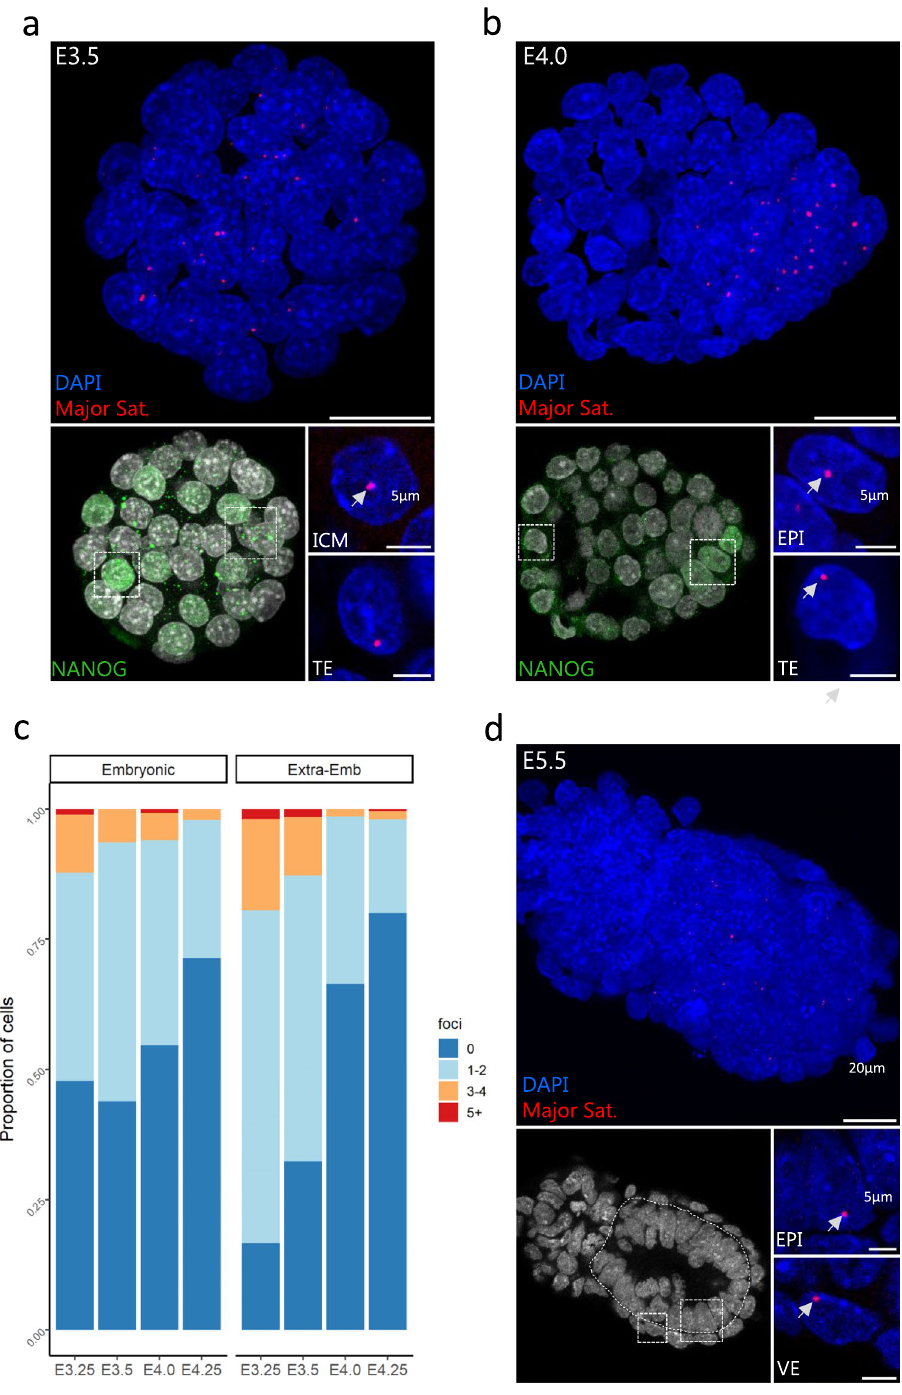
Figure 4. Transcription dynamics of major satellites in peri-implantation embryos assessed by RNA-FISH. ( a , b ) left panels show the Z-projection of whole embryos processed for immuno-RNA-FISH at E3.5 ( a ) and E4.0 ( b ). Scale bar represents 20 µm. EPI cells are either identified with NANOG staining (lower left panels, a and b ) or morphologically ( c ). Lower right panels show zoomed-in nuclei of both embryonic or extra-embryonic lineages, with DAPI (blue) and major satellite (red) signals. Scale bar is 5 µm. (d) Proportion of cells in EPI or Extra-embryonic lineages exhibiting 0, 1–2, 3–4 and 5 or more (5 +) RNA-FISH foci per cell at the different indicated blastocyst stages (3400 nuclei analysed). Graphs were generated using ggplot2 56 (v3.3.5) in R and figures were arranged with FigureJ 55 in Fiji 54